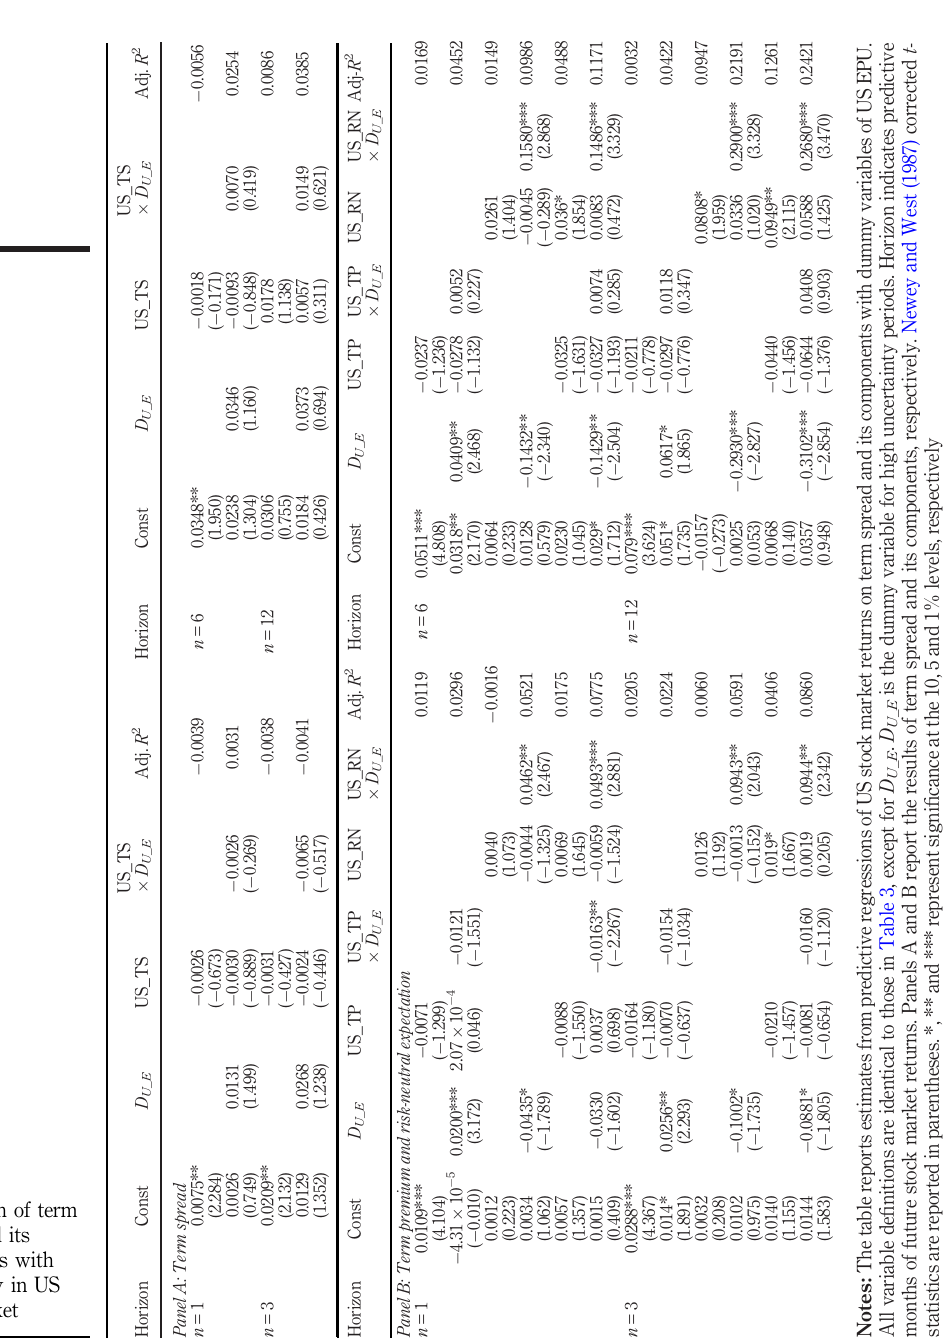
Table 7. Information of term spread and its components with uncertainty in US stock